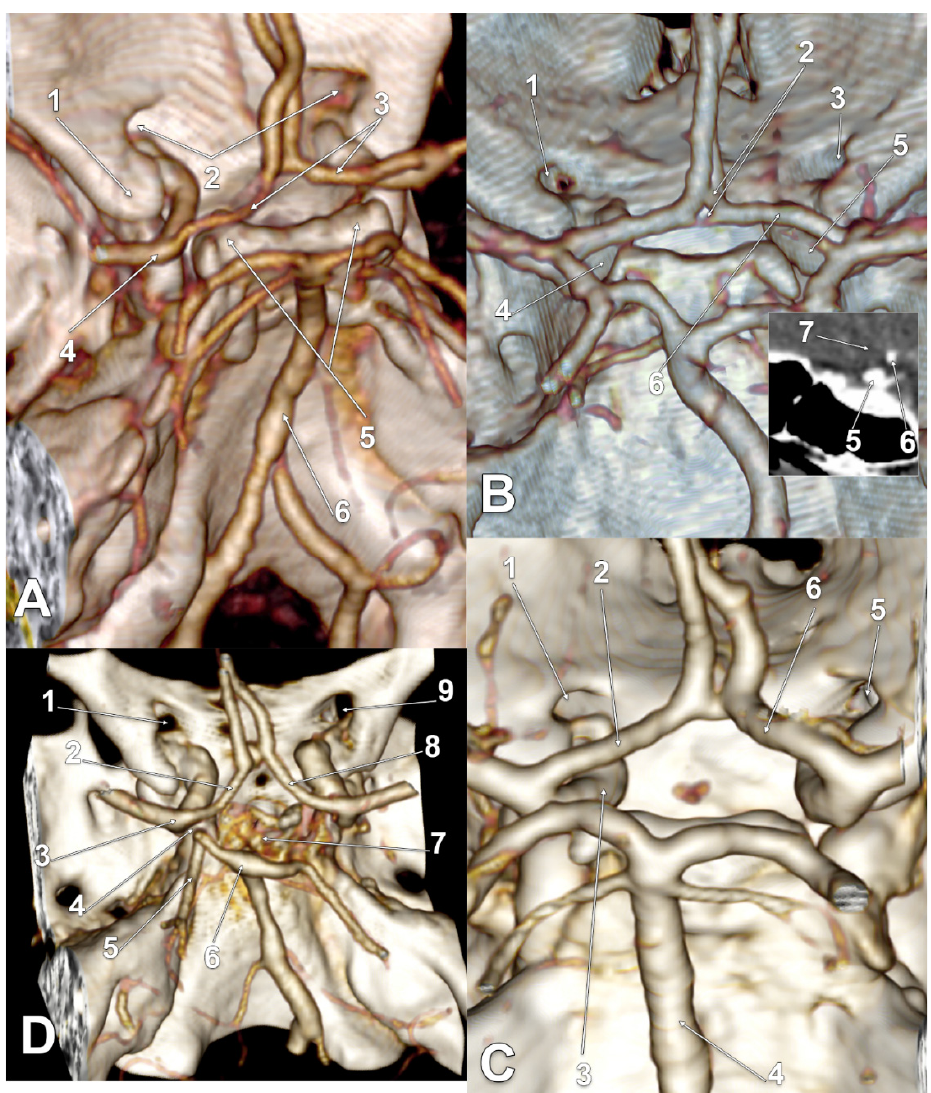
Figure 4. ( A ) Three-dimensional volume rendering of the skull base, left posterosuperior view. Bi- lateral infraoptic anterior cerebral arteries. 1. Left anterior clinoid process; 2. optic canals; 3. A1 seg- ments of the anterior cerebral arteries; 4. left internal carotid artery bifurcation; 5. posterior clinoid processes; 6. basilar artery. ( B ) Three-dimensional volume rendering of the skull base, posterosupe- rior view. Inset: sagittal slice through the right optic nerve. Bilateral infraoptic anterior cerebral ar- teries. 1. Left optic canal; 2. duplicated anterior communicating artery; 3. right optic canal; 4. left internal carotid artery; 5. right internal carotid artery; 6. infraoptic A1 segment of the right anterior cerebral artery; 7. right optic nerve. ( C ) Three-dimensional volume rendering of the skull base, pos- terosuperior view. Bilateral infraoptic anterior cerebral arteries; supracarotid left A1. 1. Left optic canal; 2. A1 segment of the left anterior cerebral artery; 3. left internal carotid artery; 4. basilar artery; 5. right optic canal; 6. A1 segment of the right anterior cerebral artery. ( D ) Three-dimensional vol- ume rendering of the skull base, posterosuperior view. Bilateral infraoptic anterior cerebral arteries. Rotated basilar artery bifurcation. 1. Left optic canal; 2. A1 segment of the left anterior cerebral ar- tery; 3. left internal carotid artery bifurcation; 4. 0.66 mm distance between the anterior and posterior cerebral arteries; 5. left posterior cerebral artery; 6. rotated basilar artery bifurcation; 7. dorsum sel- lae; 8. A1 segment of the right anterior cerebral artery; 9. right optic canal.